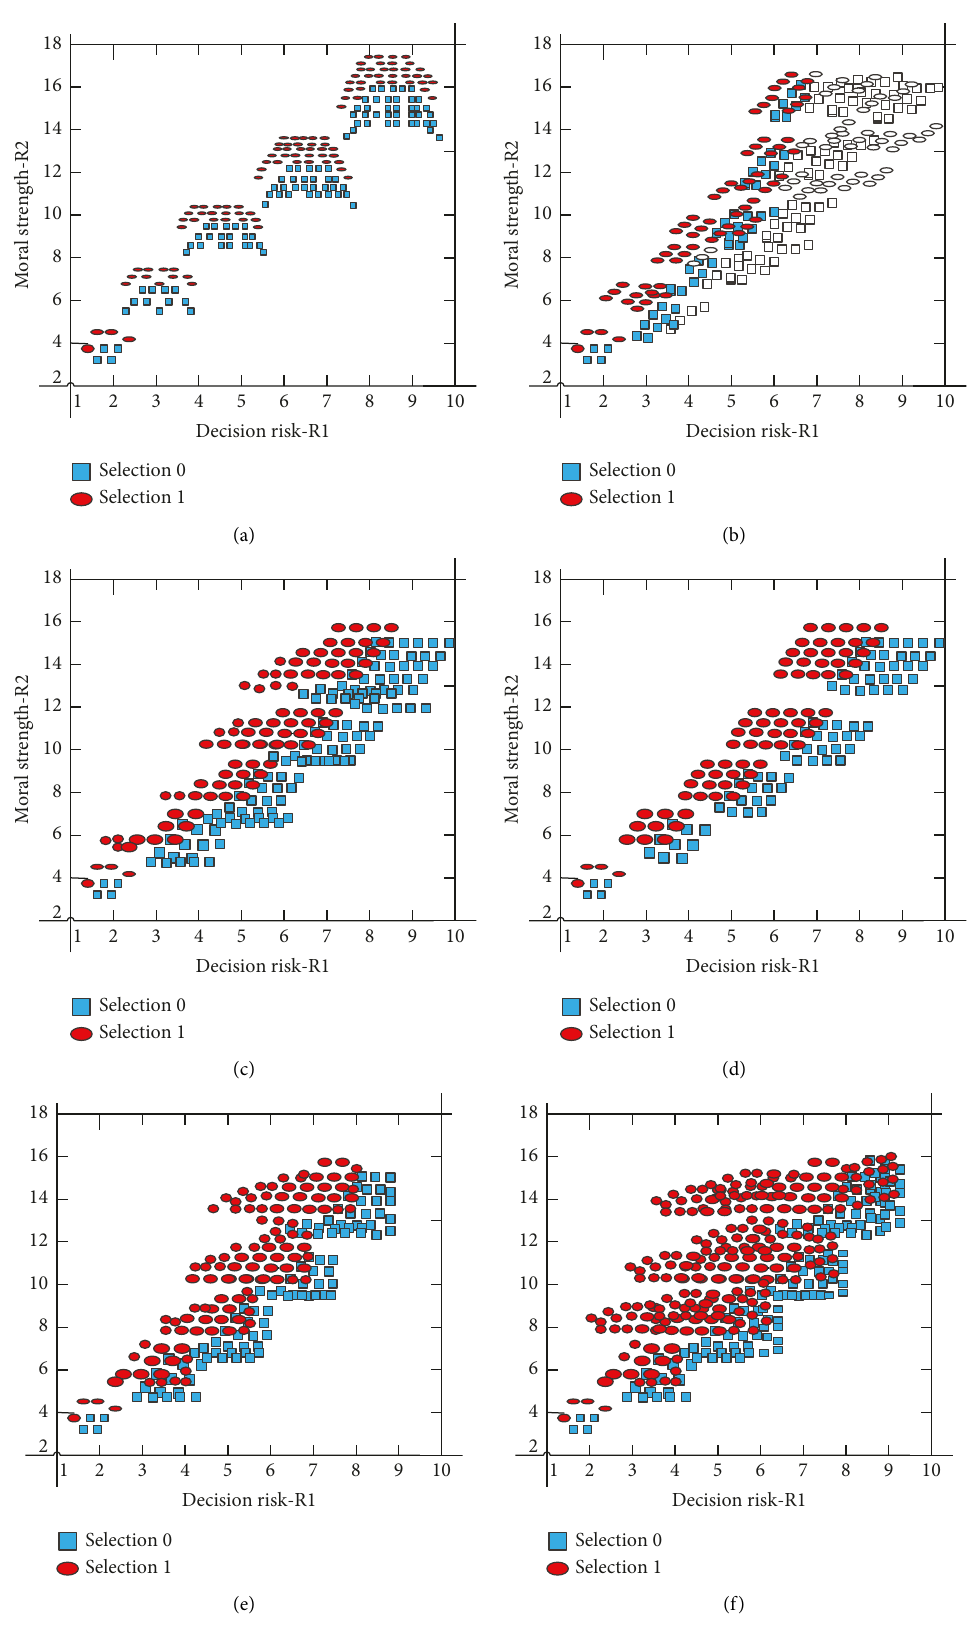
Figure 1: Distribution of decision-making features in six feature scenarios. (a) Distribution map of ethical decision characteristics in fitness feature scenarios. (b) Distribution map of ethical decision characteristics in age feature scenarios. (c) Distribution map of ethical decision characteristics in gender feature scenarios. (d) Distribution map of ethical decision characteristics in social status feature scenarios. (e) Distribution map of ethical decision characteristics in species feature scenarios. (f) Distribution map of ethical decision characteristics in utilitarian feature